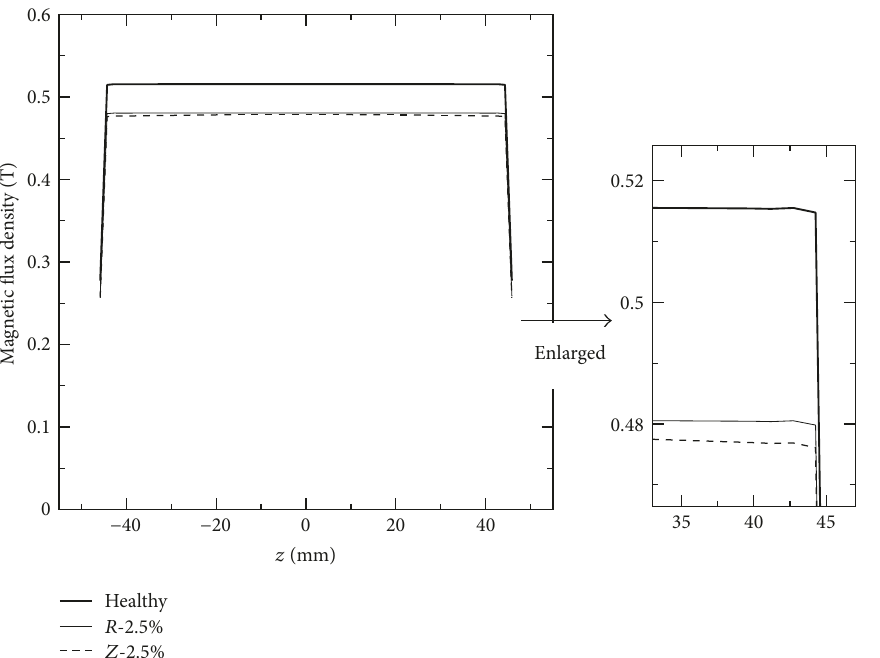
Figure 9: Calculated flux density at the center of the air-gap and 𝜃 = 315 ∘ .